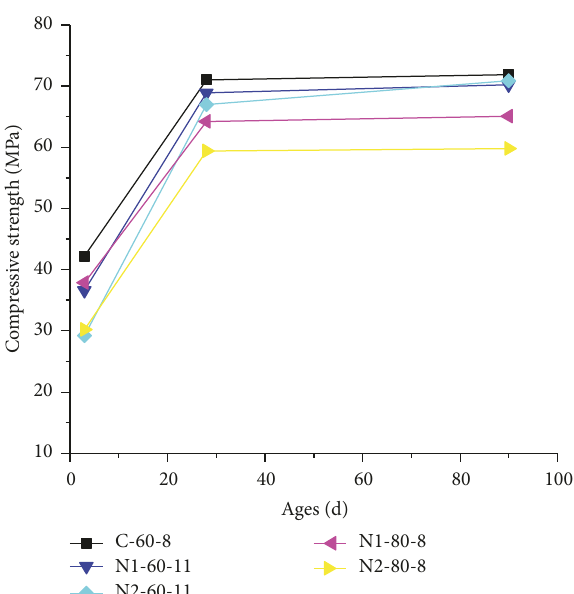
Figure 22: Chloride ion permeability of the standard-cured con- crete with W/B of